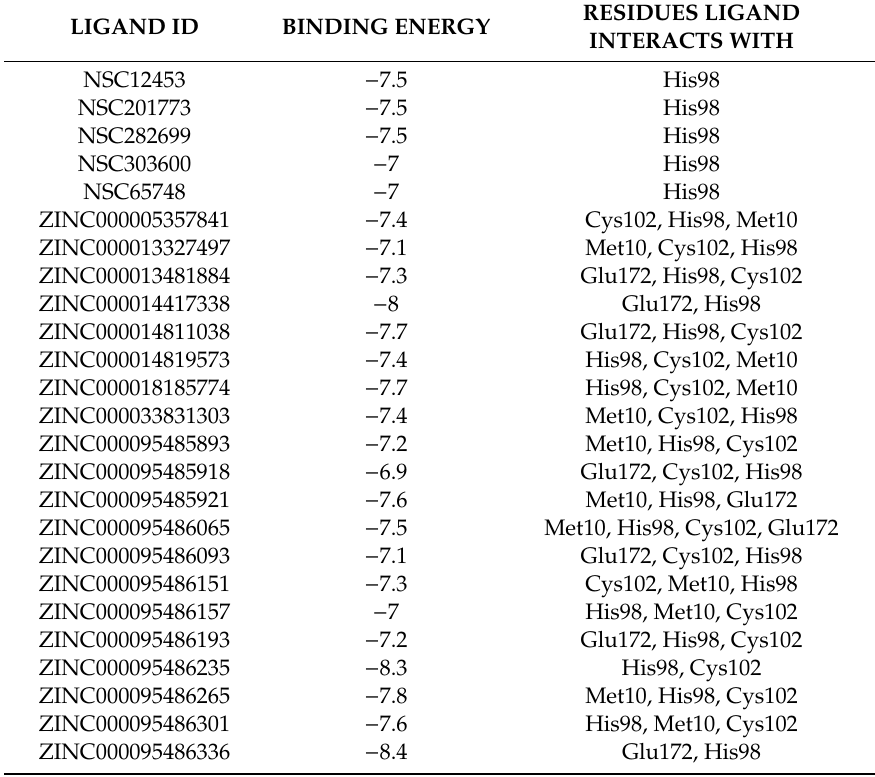
Table 3. Table of Top 20 hits and five potent inhibitors with their binding energies and interacting metal binding site-2 residues. Residues were determined using the processed_VinaResult.py script in the Autodock tools